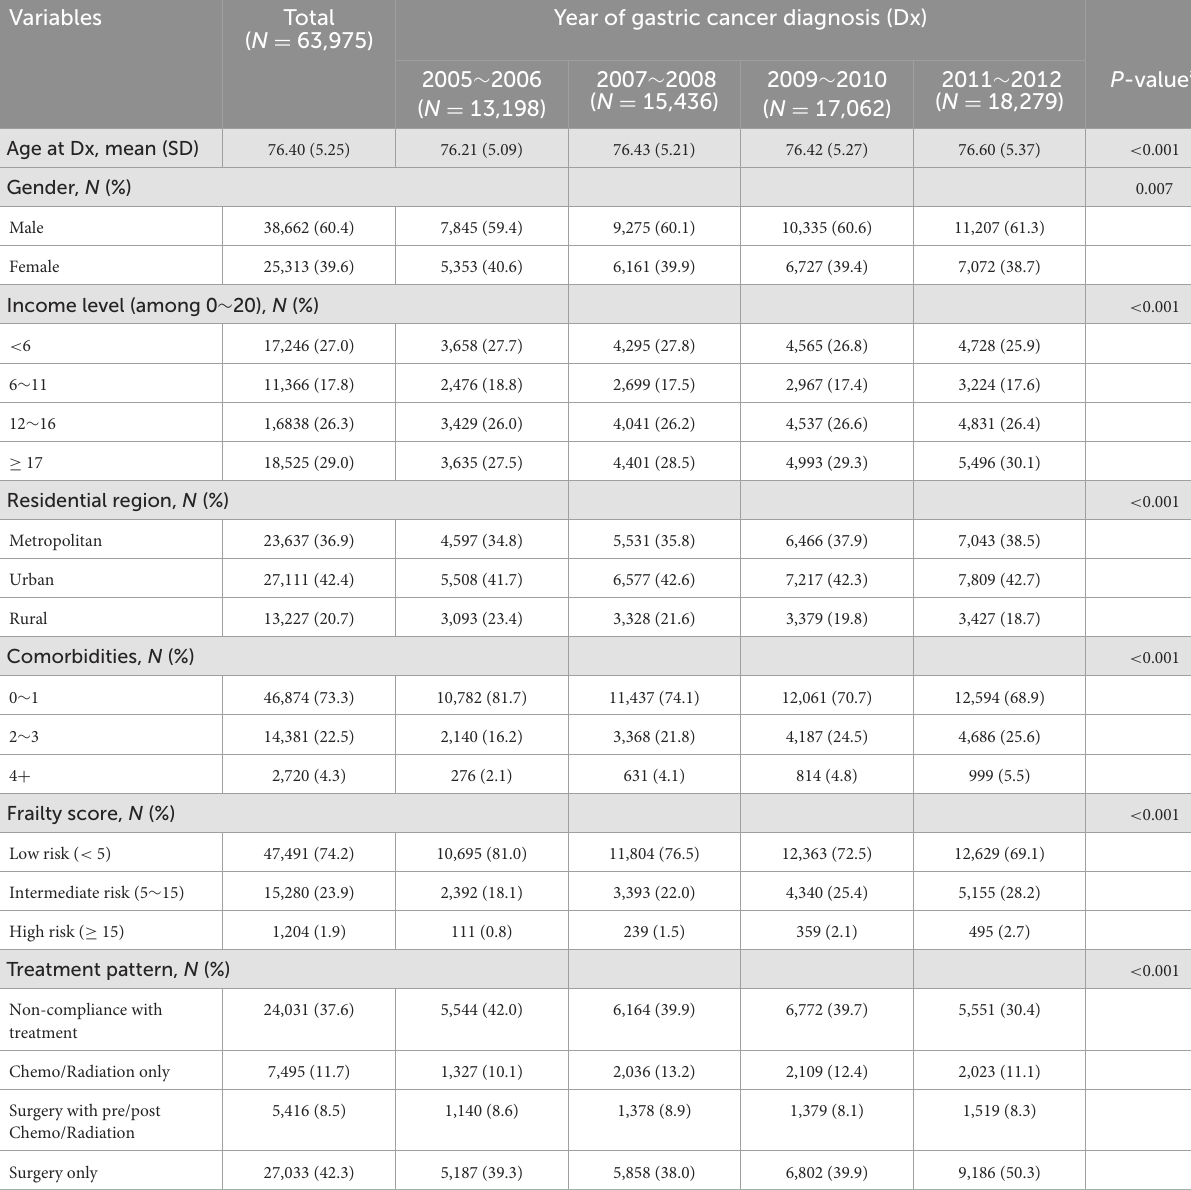
TABLE 1 Baseline characteristics of the study population by the four time periods of gastric cancer diagnosis.